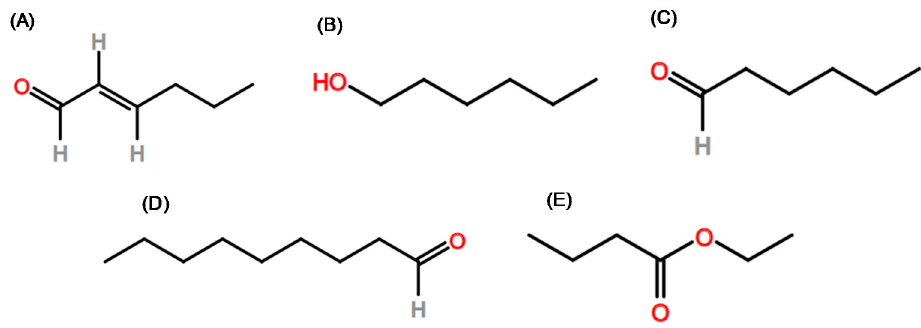
Figure 3. Molecular structure of ( A ) (E)-2-hexenal, ( B ) 1-hexanol, ( C ) hexanal, ( D ) nonanal, and ( E ) ethyl butanoate.